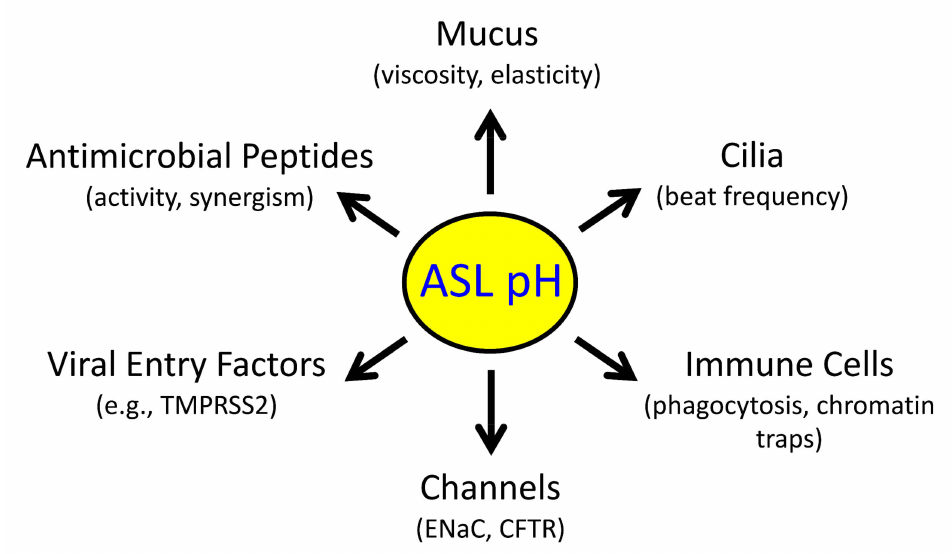
Figure 1. pH ASL influences respiratory host defenses. The acid–base balance of ASL controls key first-line airway host defenses including secreted antimicrobial peptide activity and synergism against inhaled bacteria; mucus viscosity and elasticity; ciliary beat frequency (CBF) # ; innate immune cell activities such as phagocytosis and extracellular killing of microbes through release of